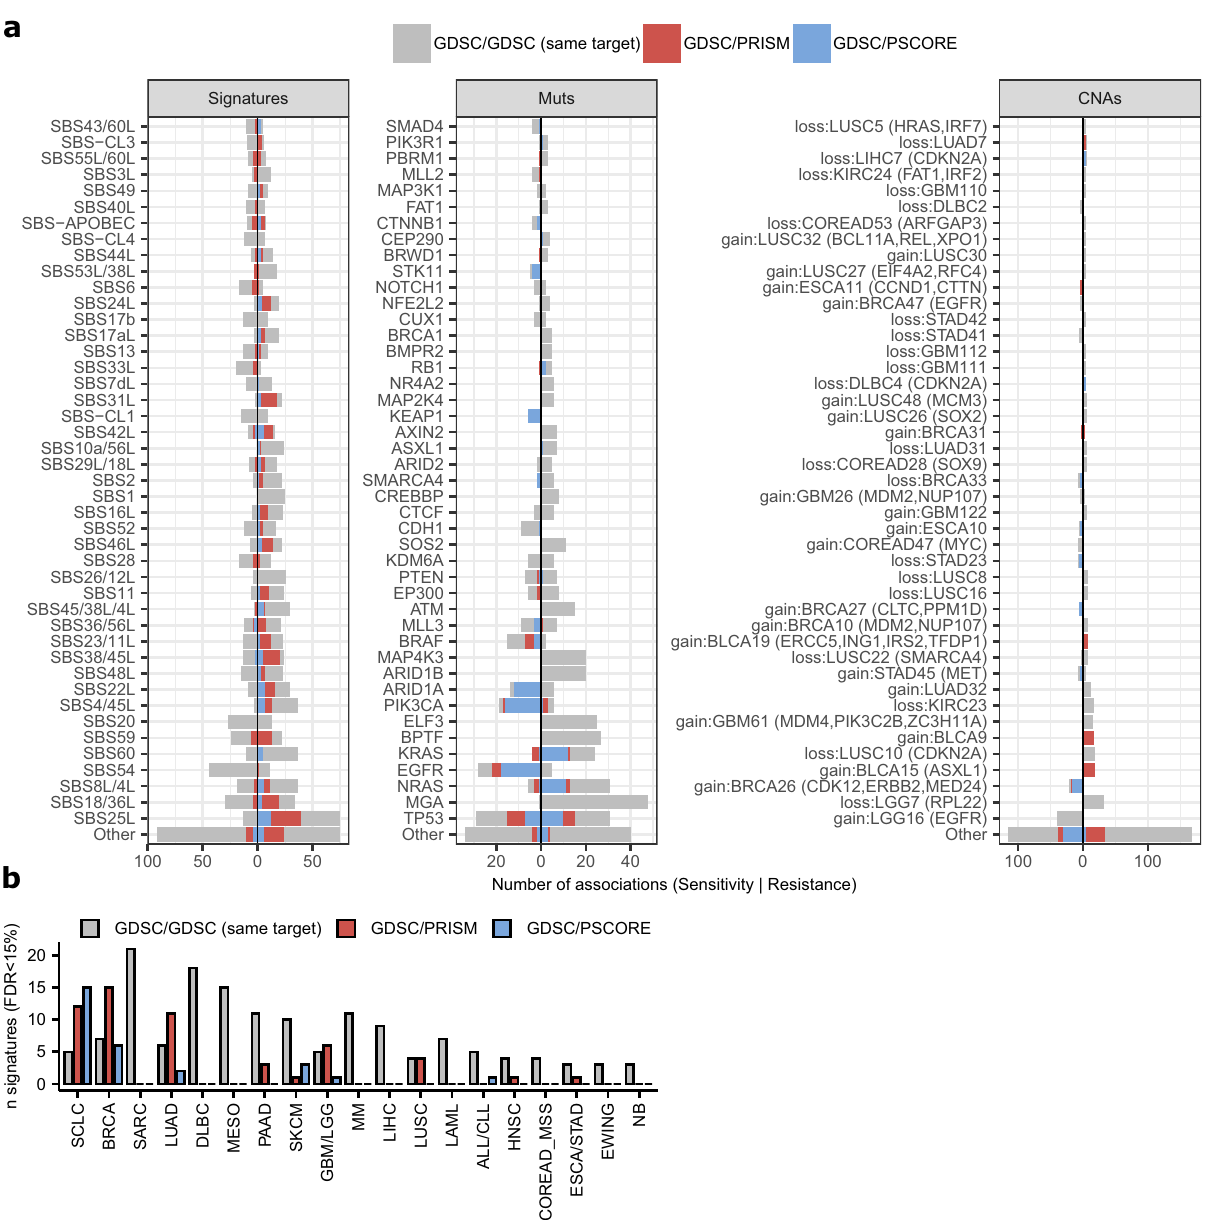
Fig. 4 Tally of the signi fi cantly replicated associations of drug sensitivity or resistance with mutation signatures and other markers. a Comparison of the number of statistically signi fi cant associations (FDR<15% by randomization test, additionally requiring an effect size d > 0.5 for GDSC/PRISM and GDSC/PSCORE tests, and d > 1 for the GDSC/GDSC (same-target) test) per feature, among mutational signatures ( “ Signatures ” ), oncogenic mutations ( “ Muts ” ) and copy number alterations ( “ CNAs ” ) in the three types of replication tests (see Fig. 3a). Features are ranked by the total number of signi fi cant associations, either for drug sensitivity (negative side of X-axis) or resistance (positive side of X-axis). b The number of different mutational signatures that have statistically signi fi cant associations across various cancer types (at FDR<15%; we consider signatures that have >1 signi fi cant association per cancer type), in the three replication tests. Source data are provided as a Source Data fi